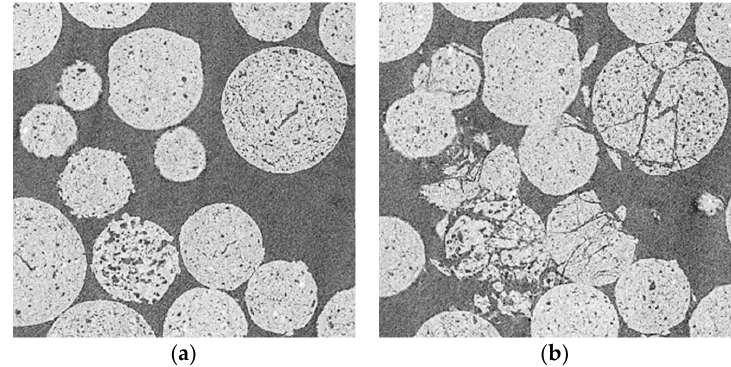
Figure 2. Corresponding fragments of 2D slices: ( a ) slightly loaded; ( b ) after axial stress impact.